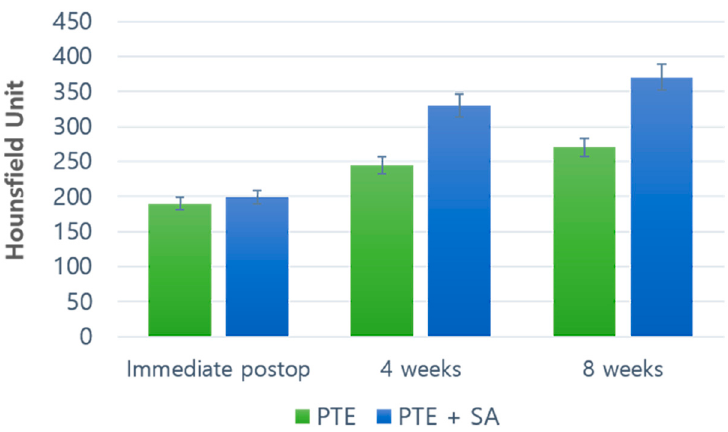
Figure 2. Hounsfield unit of the PTE group and the PTE + SA group.